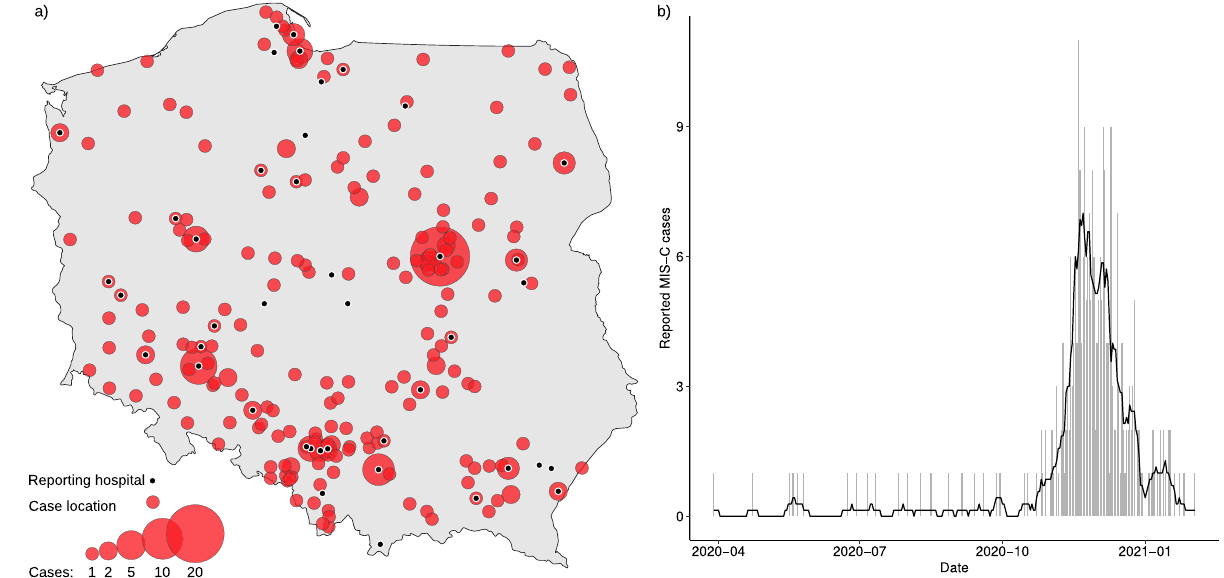
Figure 1. Geospatial and temporal distribution of analyzed cases. ( a ) Shows locations of analyzed cases and reporting sentinel sites. ( b ) Shows the counts MIS-C hospitalisations in respective days in the analyzed period, between 4th March 2020 and 20th February 2021. Bars indicate daily counts, while the black line presents the 7-day moving average.